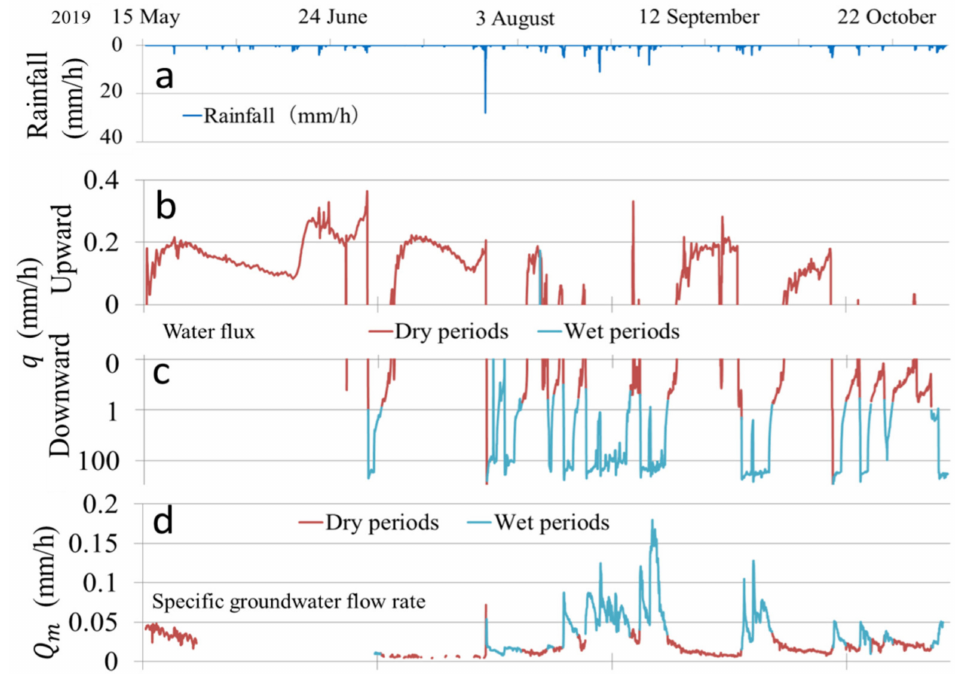
Figure 11. ( a ) Rainfall, ( b ) upward and ( c ) downward water flux at Point T, and ( d ) rate of specific groundwater flow at the midpoint between Points A and